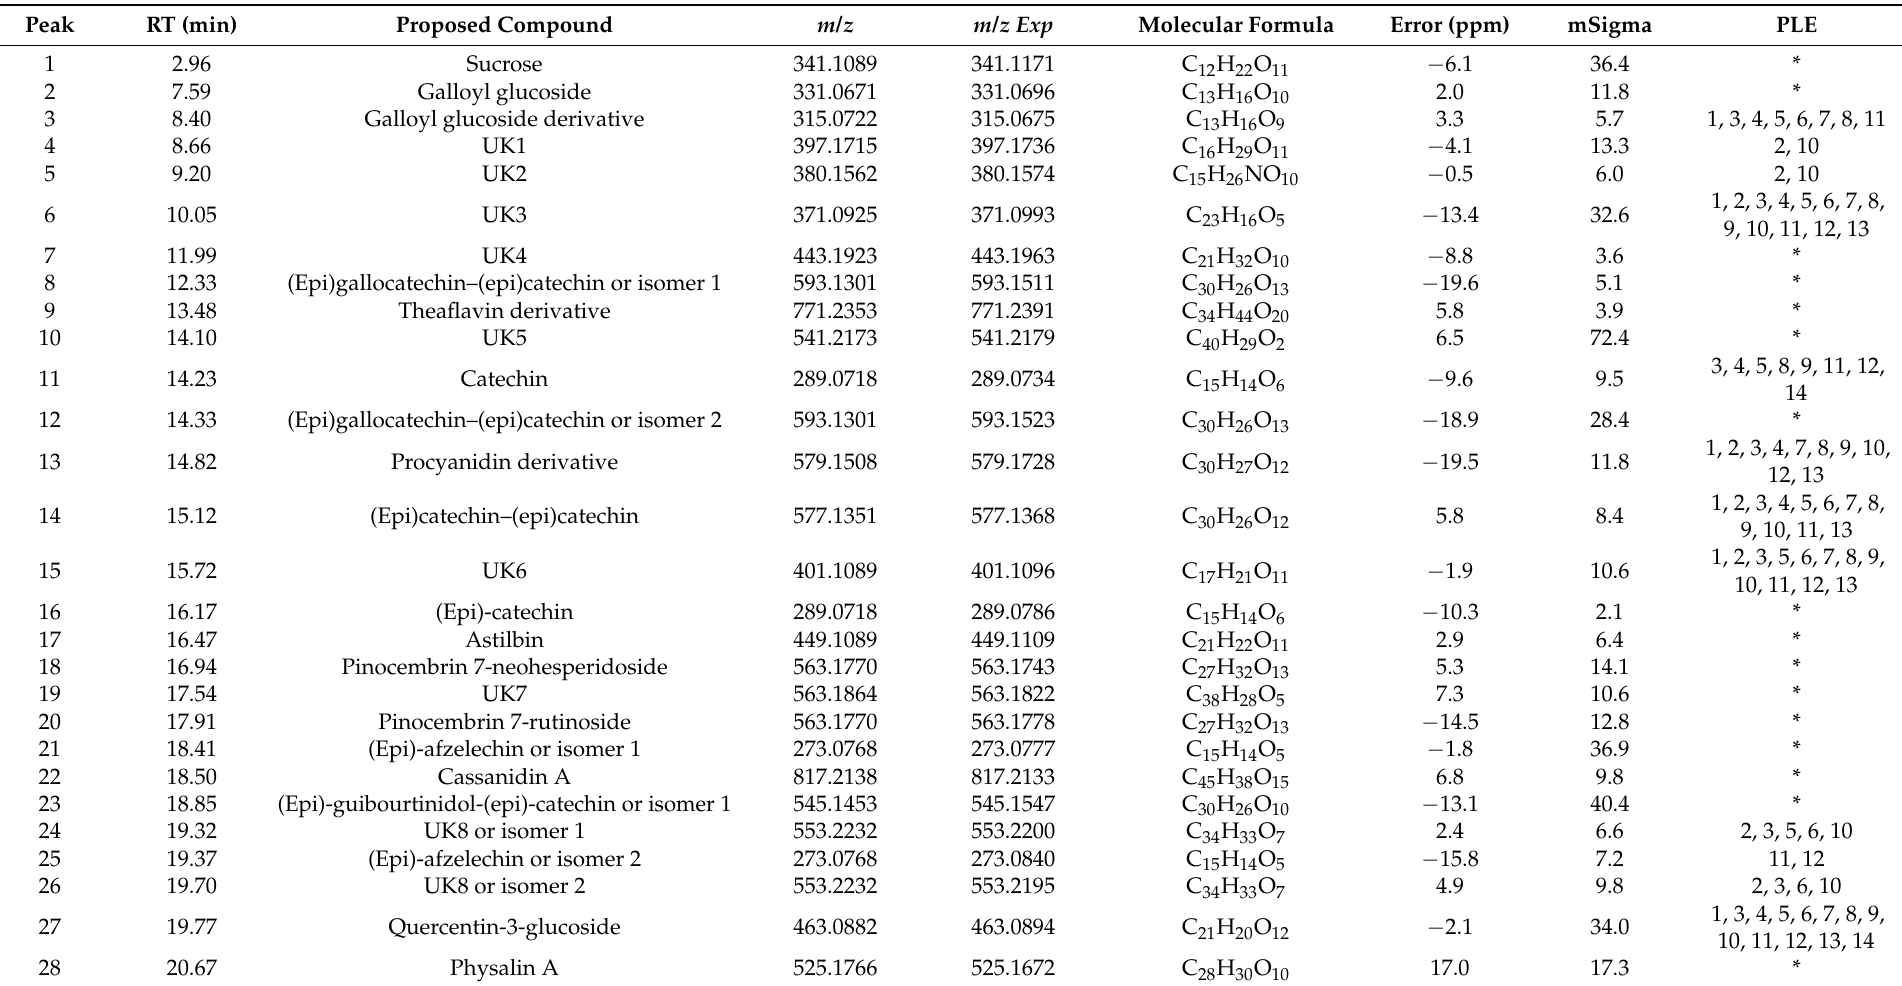
Table 2. Phenolic and other polar compounds of C. grandis PLE extracts characterized by